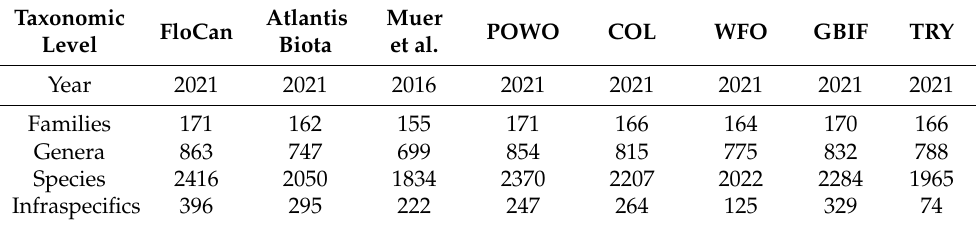
Table 1. Numbers of accepted plant taxa (families, genera, species, subspecies, varieties) in the FloCan checklist for the Canary Island archipelago in comparison with other current plant lists (Atlantis, Muer) and with reference to the accepted taxa in international taxonomic data bases Plants of the World Online (POWO), Catalogue of Life (COL), World Flora Online (WFO), GBIF and TRY. Taxonomic